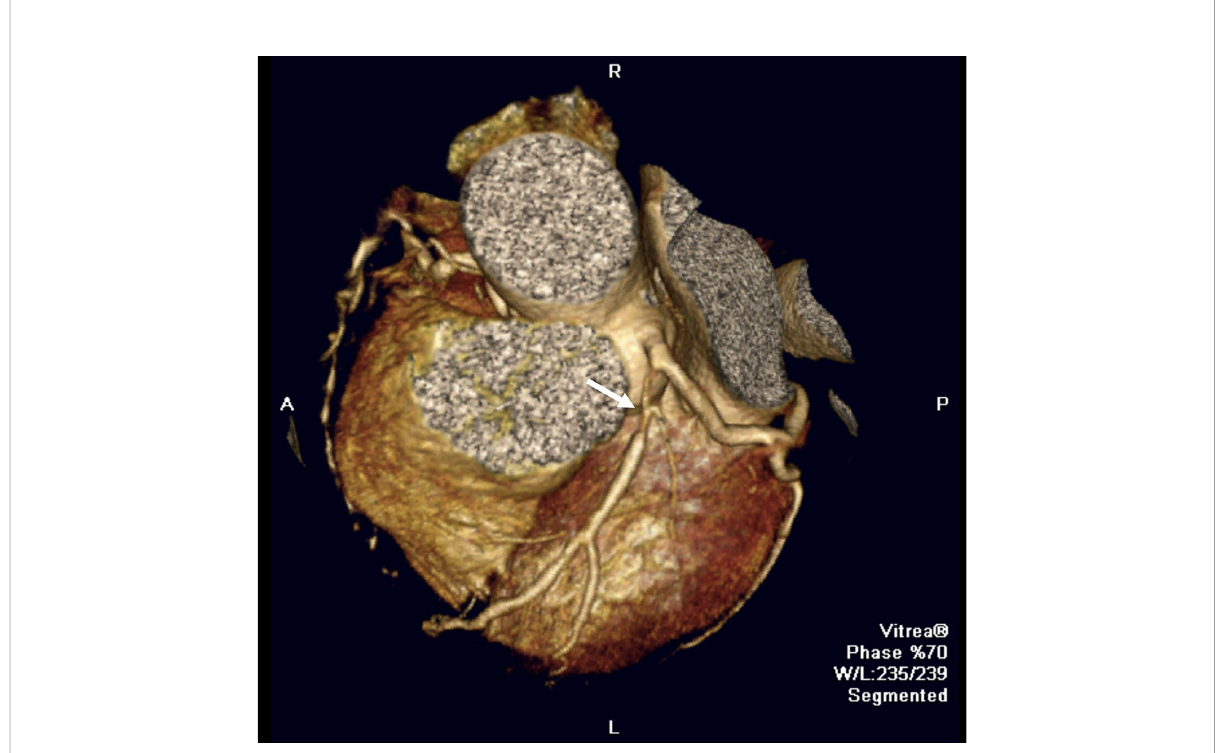
FIGURE 2 Cardiovascular manifestations in SLE. Coronary computed tomography image showing a severe stenotic lesion in the proximal segment of the left anterior descending coronary artery (white arrow) in a SLE